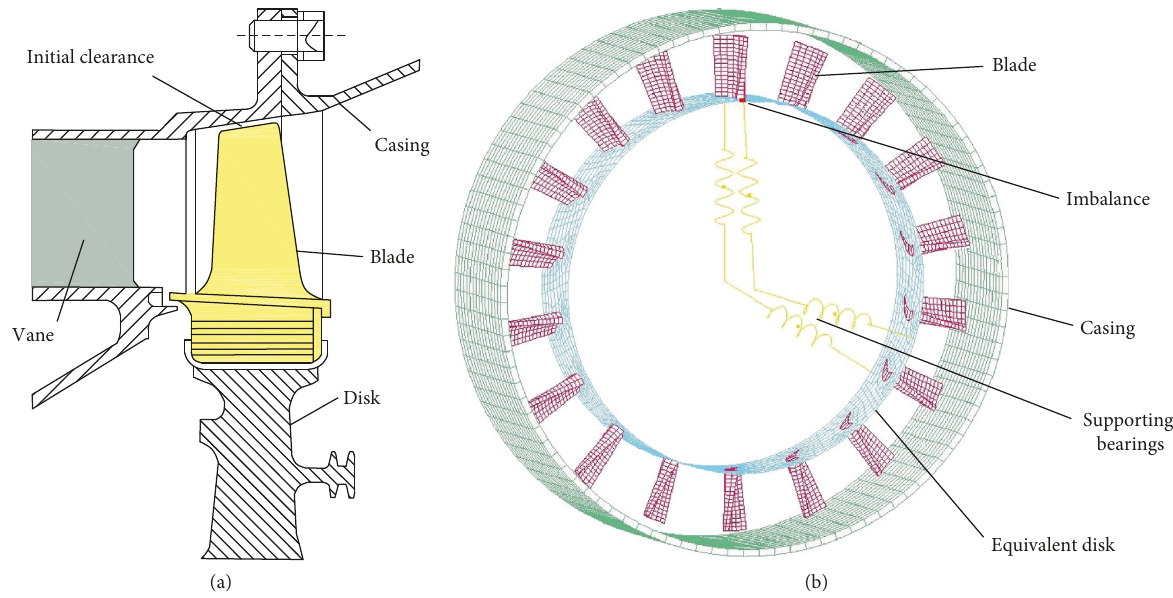
Figure 15: Analysis model of an actual turbine blade-casing system. (a) Sketch. (b) FE model.